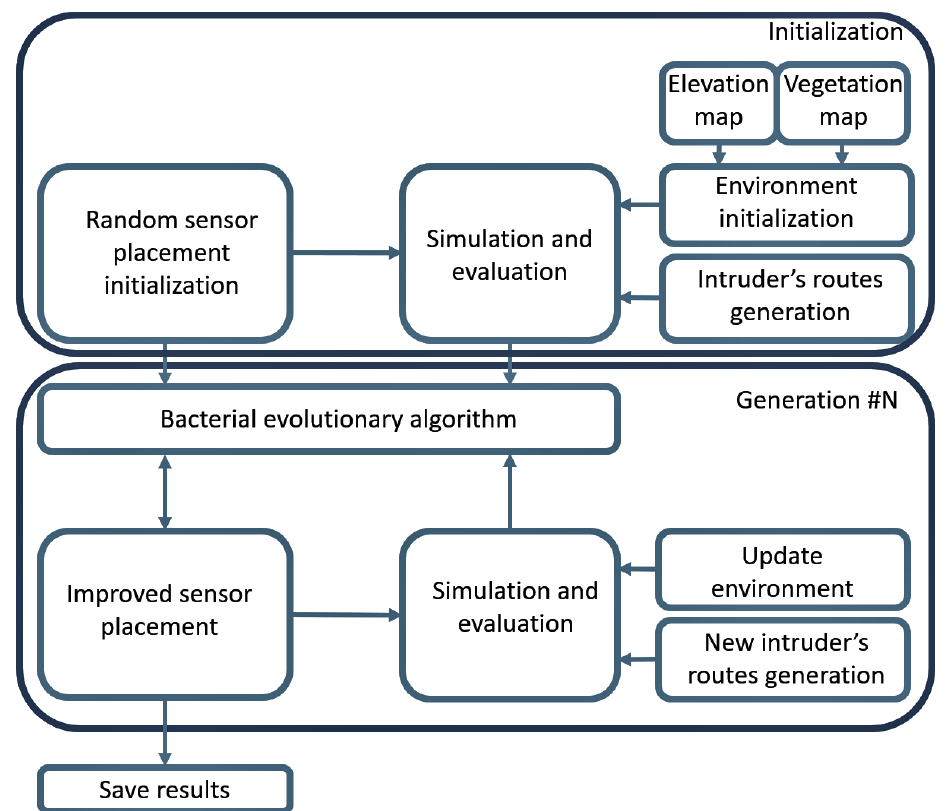
Figure 8. Optimization flow